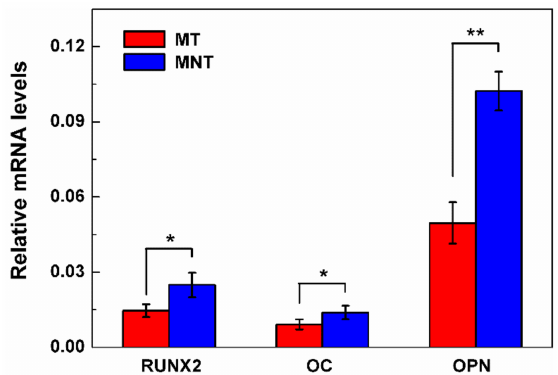
Figure 14. Relative expression of Runx2, OC and OPN in hBMSCs seeded on MT or MNT coated-surface, hBMSCs have a cultivation of 14 days in osteoinduction medium. All values normalized to beta-actin. (* represents p < 0.05, ** represents p <